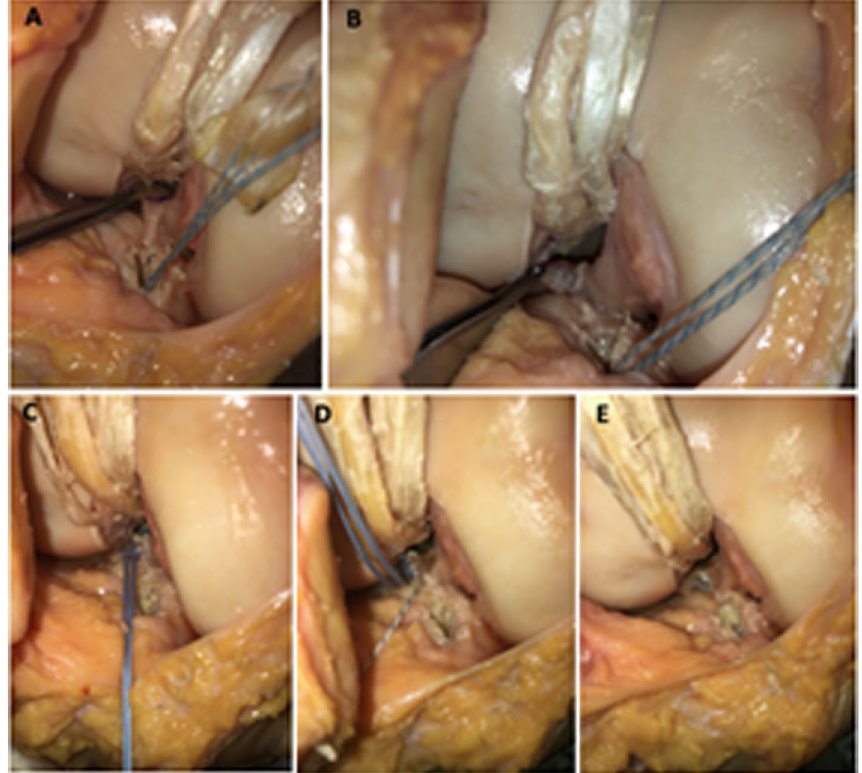
Fig. 2 A Posterior lateral meniscal root marked at 8 mm from the center of its attachment site. B PLMR with segmental meniscal root loss and intact MFL. C PLMR with two meniscal repair stitches passed in luggage-tag fashion. D MFL with an imbrication stitch passed in luggage-tag fashion. E Completed PLMR root in-situ repair and augmentation with MFL